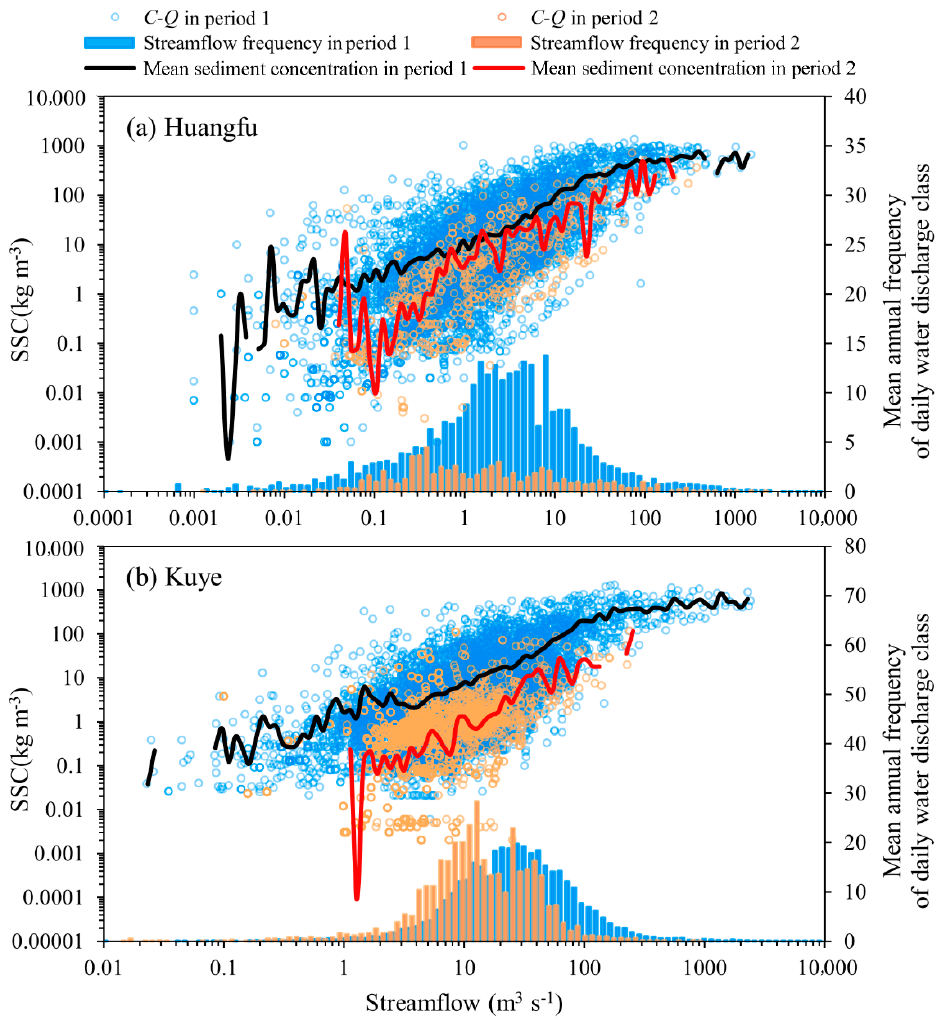
Figure 8. Comparison of daily C-Q relationship at 100 discharge classes between the baseline period and change period in the Huangfu basin ( a ) and the Kuye basin ( b ).